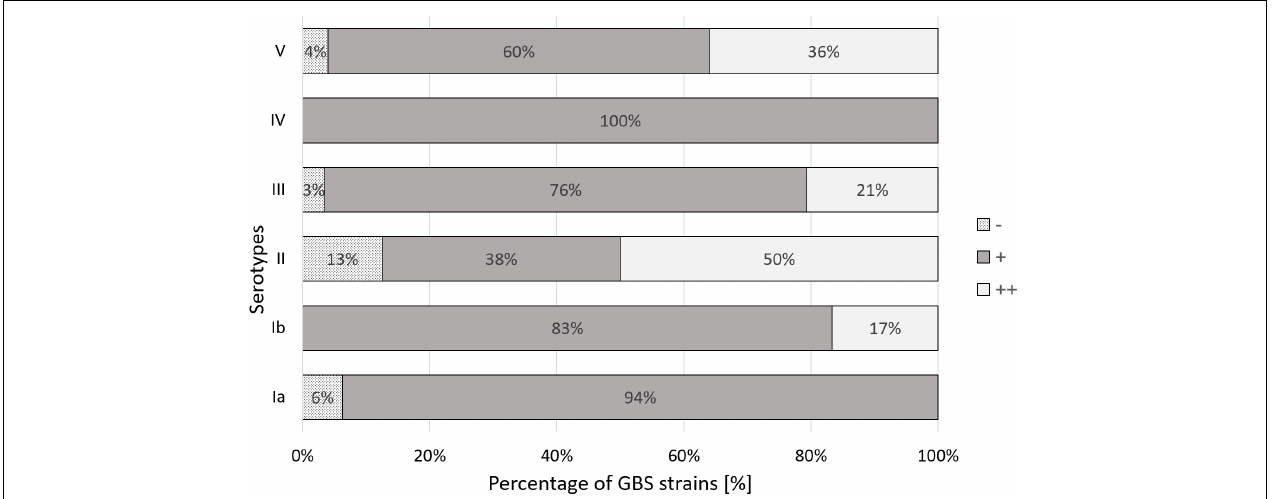
FIGURE 5 | Percentage distribution of the degree of human bladder microvascular endothelial cell line (HMVEC-Bd) adherence among Ia, Ib-V serotypes of GBS. (–) – no adherence, (+) – weak adherence, (++) – moderate adherence. Significance of the association between serotype and bacterial adherence capacity equaled p = 0.044.